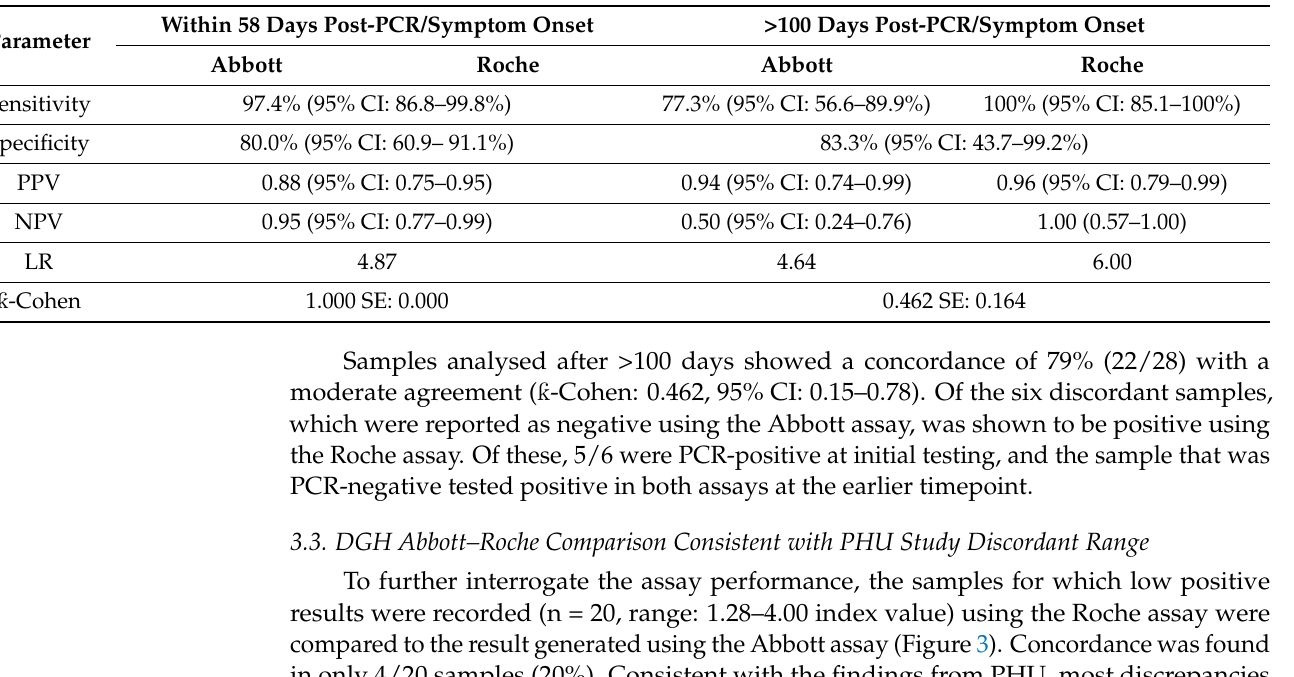
Table 1. Assay performance characteristics of Roche and Abbott in analysis of HCWs samples both within 58 days and >100 days of PCR result or symptom onset. Specificity was assessed using PCR-negative or no-onset of COVID-19 symptoms samples and sensitivity was assessed using RT-PCR positive samples. CI = Confidence interval. SE = Standard error.